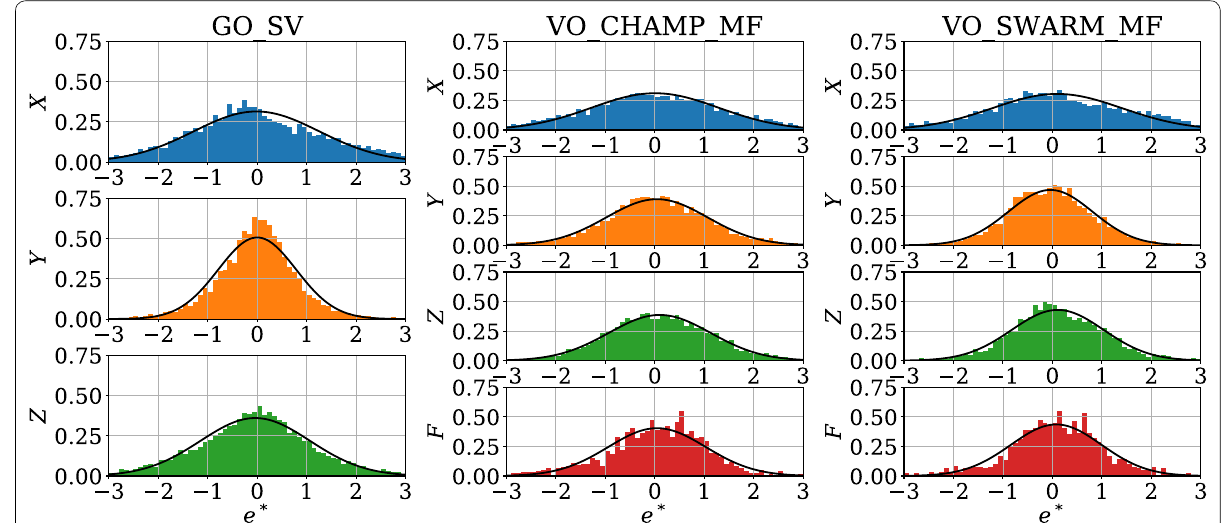
Fig. 3 Histograms of the normalized data misfit e ∗ for the GO and VO datasets (separated all three components). In black is the normalized Gaussian curve N (µ , σ) with µ the mean and σ the standard deviation of the normalized misfits (see Table